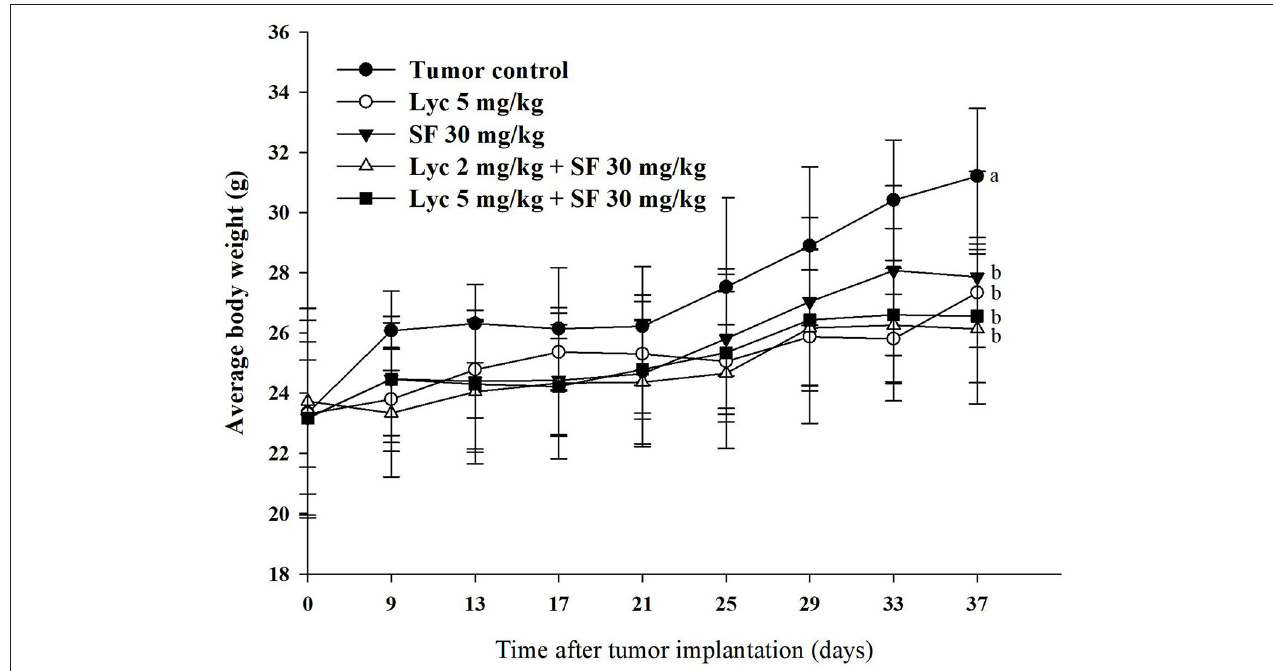
FIGURE 1 | Effects of lycopene (Lyc) alone, sorafenib (SF) alone, or their combination on the body weight change in the C57BL/6 mice xenografted LLC cells during entire experimental period. LLC cells were injected subcutaneously into the right flank of the C57BL/6 mice. Nine days after the tumor cell injection, mice were orally